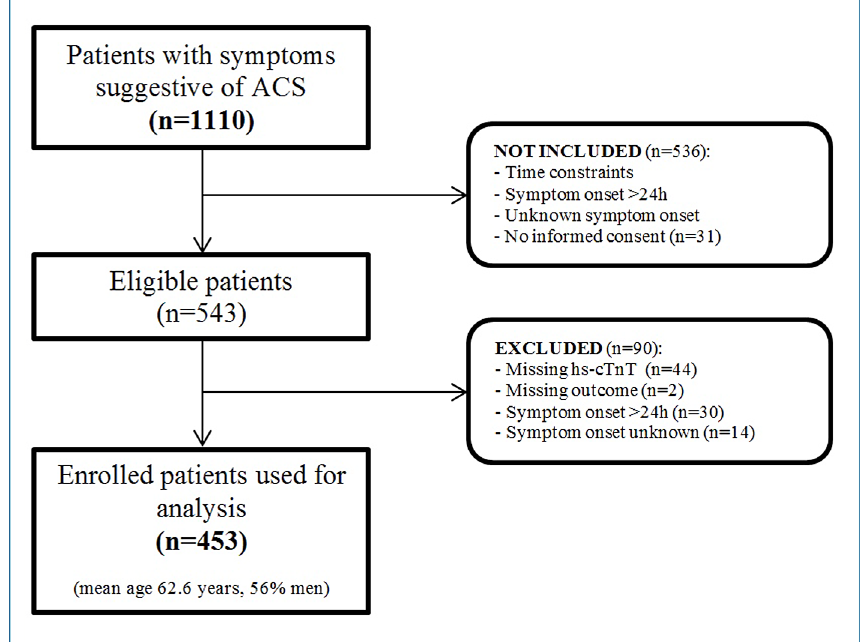
Fig 1. Flow chart of patient selection from all patients with symptoms suggestive of ACS to enrolled patients. (Table 4). On average, the PPVs increased and the NPVs decreased compared to the overall group. Strong clinical predictors for the presence of ACS were age (OR 1.05 per year), male gender (OR 1.63), a history of hypertension (OR 2.24), hypercholesterolemia (OR 1.71) or heart failure (OR 3.99), MI on ECG (OR 5.31) or ischemic ECG (OR 7.87) and the use of aspi-